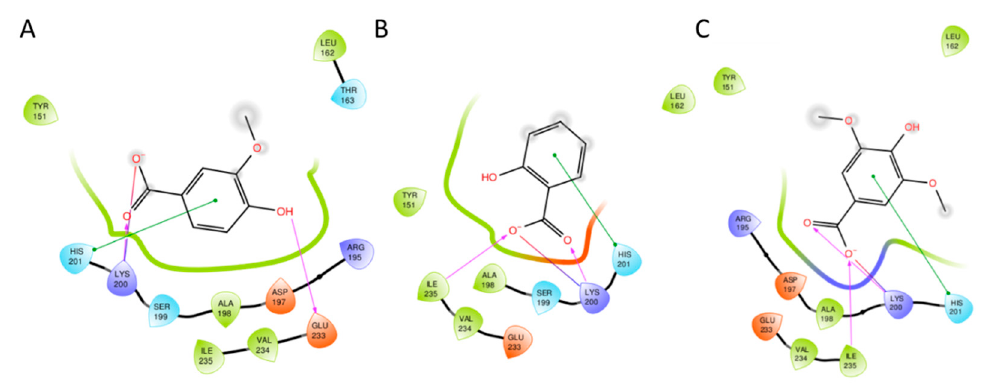
Figure 7. Binding mode of vanillic acid ( A ; 5 Gscore = − 4.65 kcal / mol), salicylic acid ( B ; 3 Gscore = − 4.84 kcal / mol) and syringic acid ( C ; 1 Gscore = − 4.32 kcal / mol), to human pancreatic α -amylase. Salt bridge interaction is depicted with a continuous blue / red faded line. Hydrogen bonds are shown with magenta arrows. Polar and hydrophobic contacts between ligand and enzyme residues are displayed with blue and green faded tick lines,